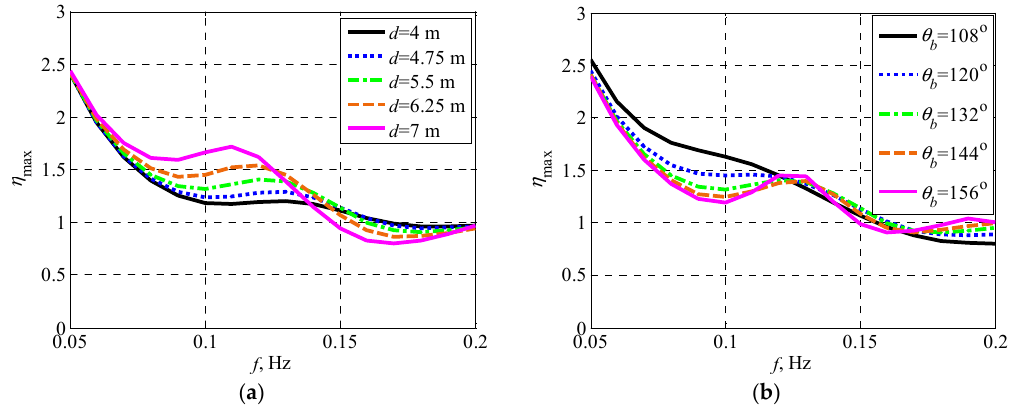
Figure 9. Maximum relative capture width as a function of wave frequency at different floating states: ( a ) for fixed beak angle at θ b = 144°; and ( b ) for fixed depth of rotation axis at d = 5.5 m.